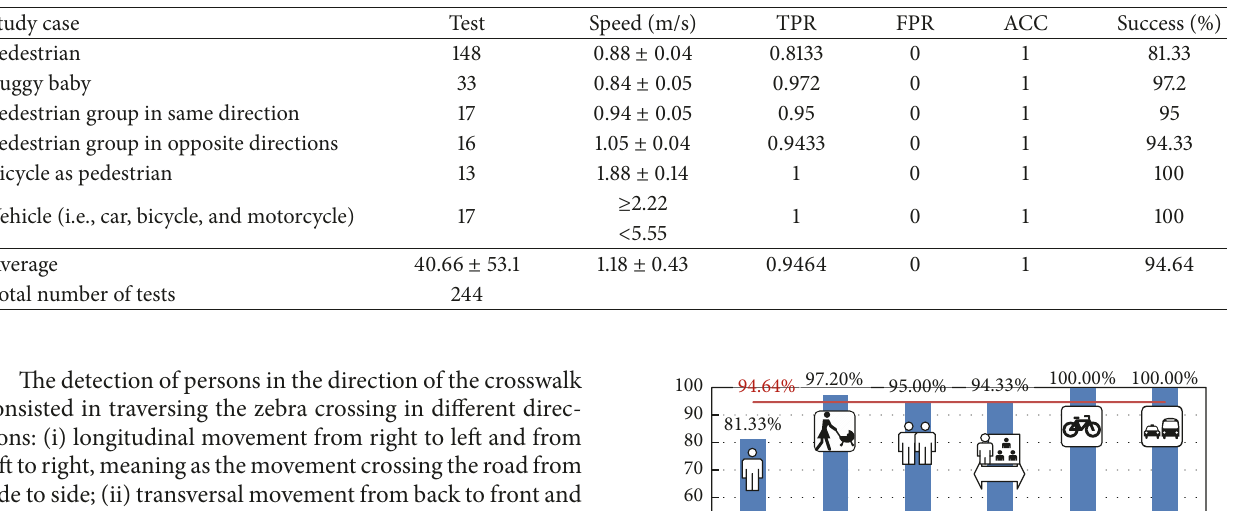
Table 8: Results obtained in the ROC analysis.